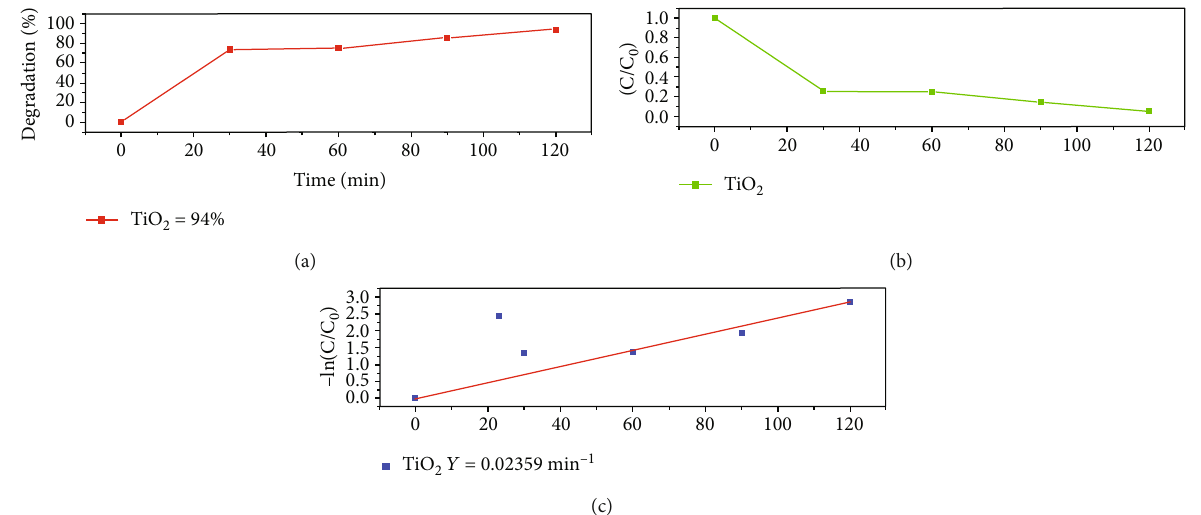
absorption rate, and (c) photocatalytic 0